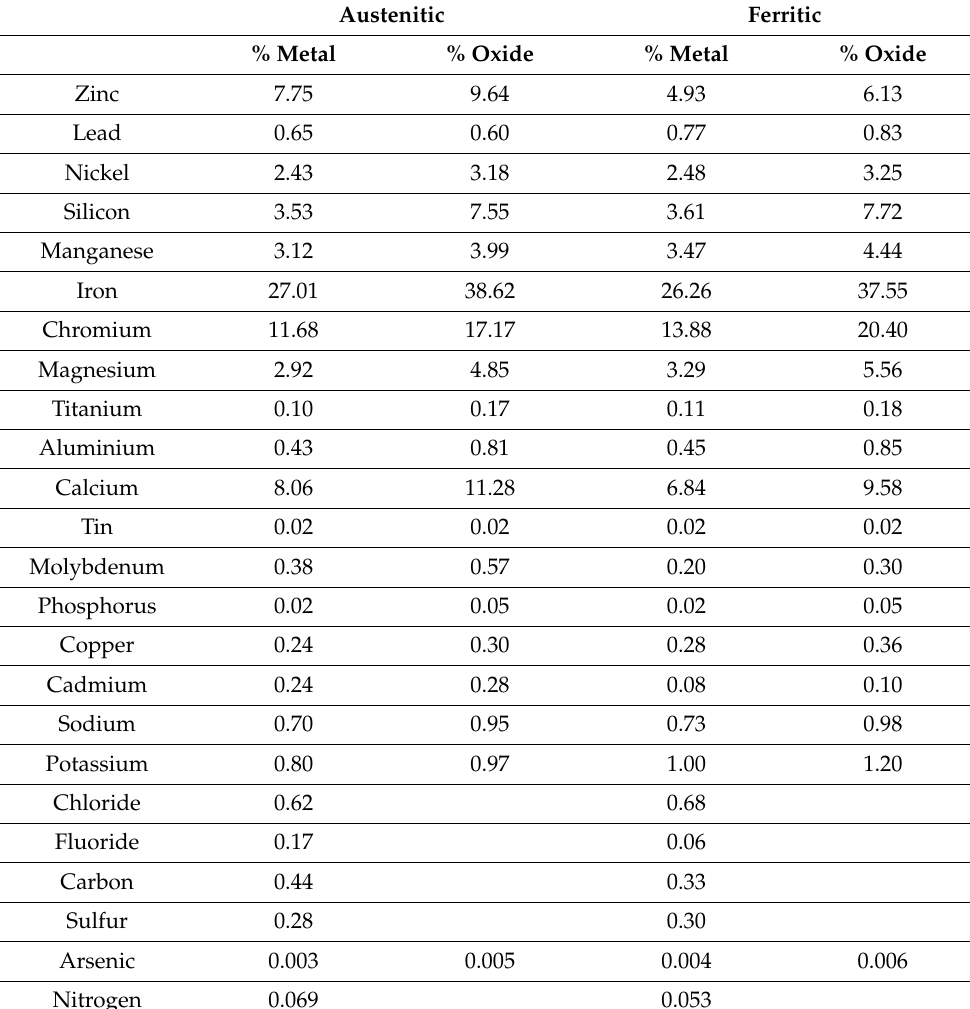
Table 2. Typical composition of metals in flue